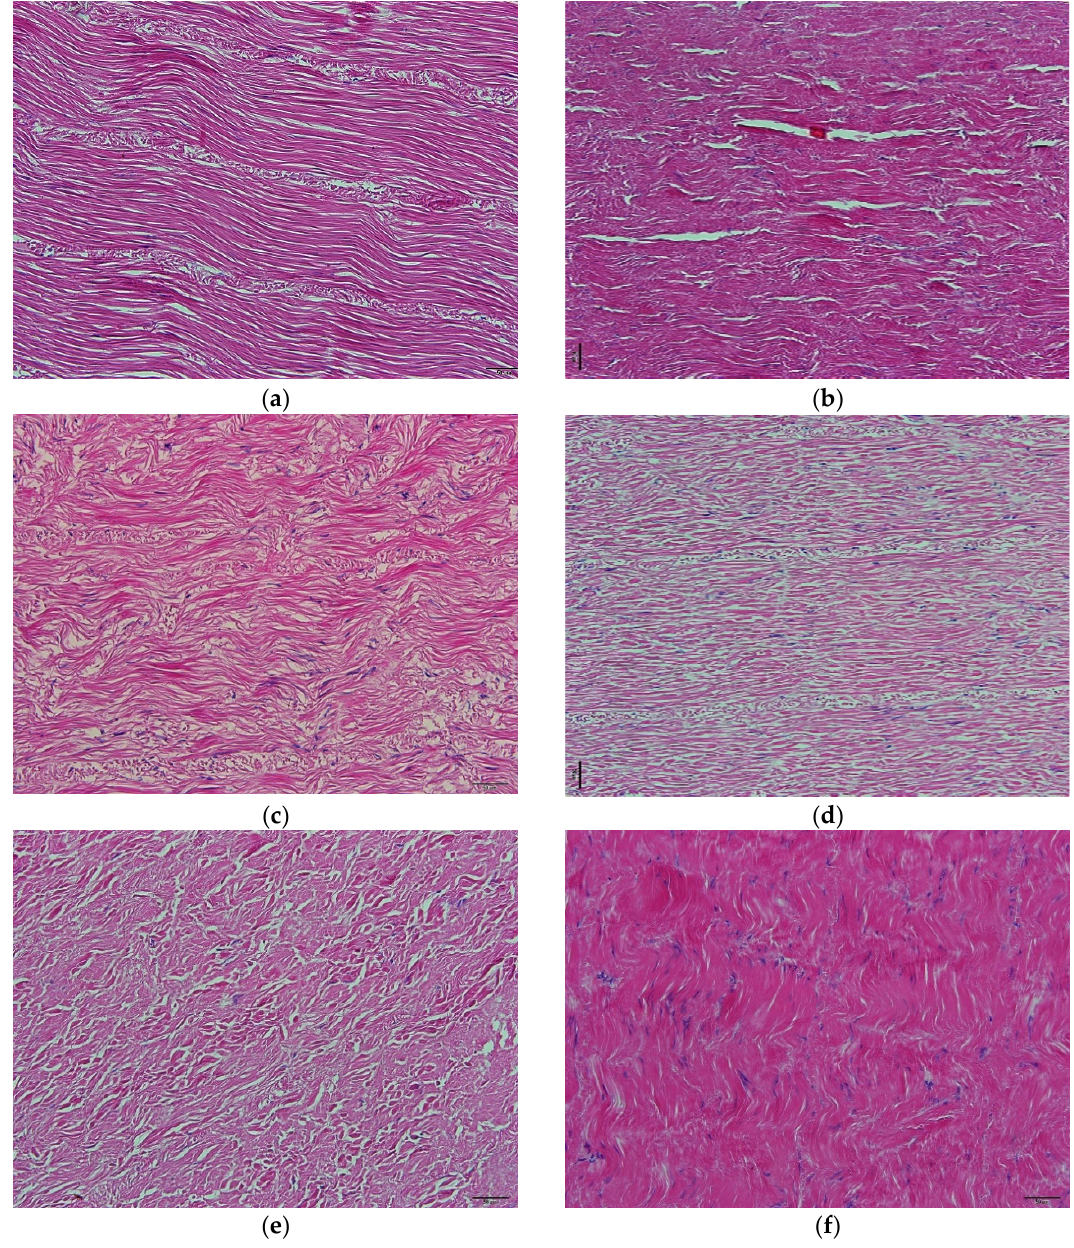
Figure 2. Histological sections of neritic squid mantle muscle (all × 200): ( a ) raw; ( b ) injected with papain; ( c ) soaked in papain with vacuum orbital shaking; ( d ) soaked in papain with ultrasonic processing; ( e ) soaked in NaHCO 3 solution with ultrasonic cleaning; ( f ) rehydrated after hot-air drying.